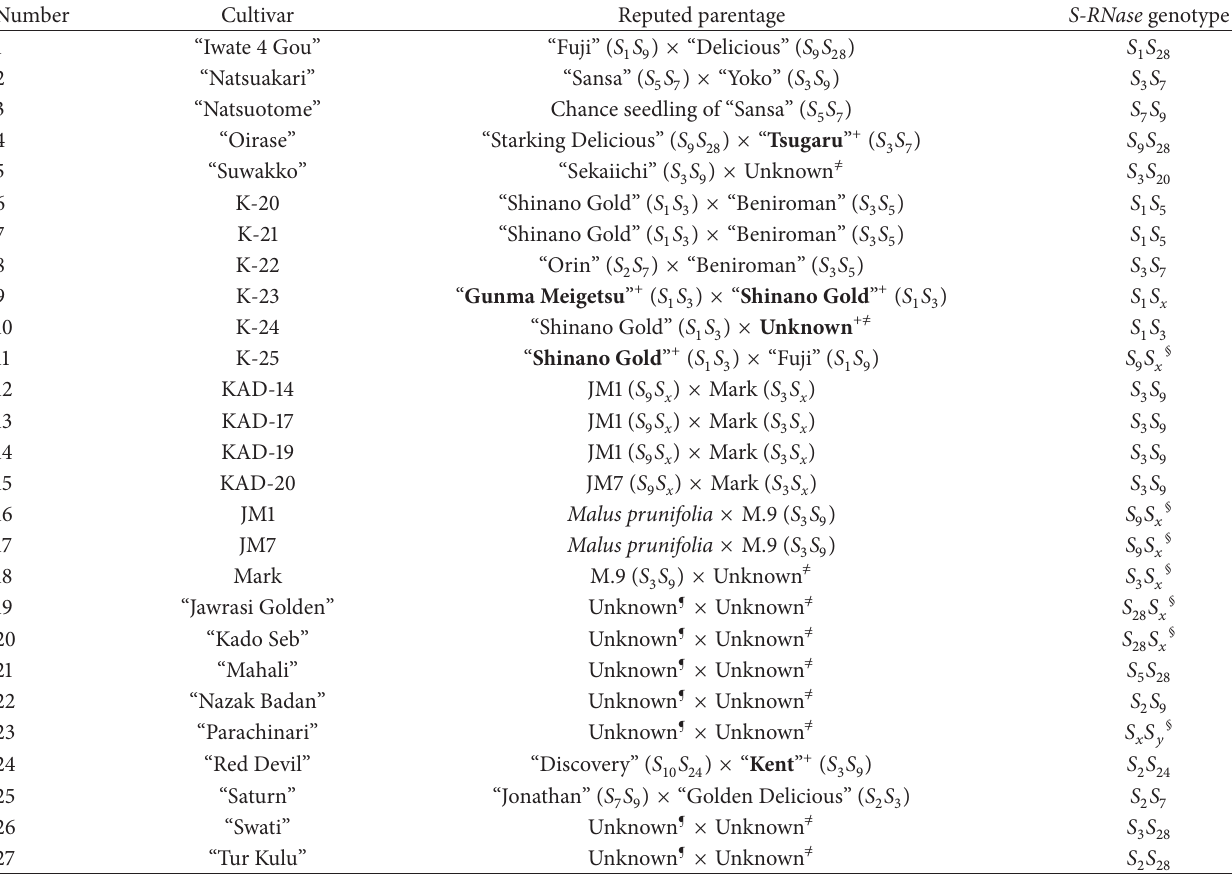
Table 1: S - RNase genotypes of 20 apple cultivars and 7 rootstocks including their